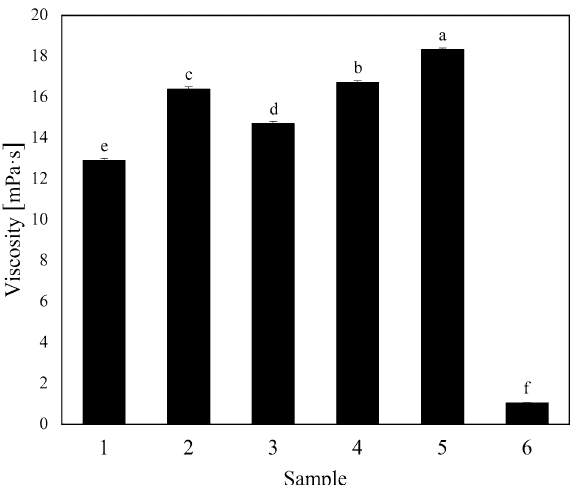
Figure 4. Viscosity of each sample. Different letters ( a–f ) indicate significant differences between means. Means followed by the same letter are not significant at the 5% significance level by the LSD test (LSD = 0.05). Vertical bars indicate a standard deviation of the mean. The detailed data of the histogram is shown in Supplementary Table S4.